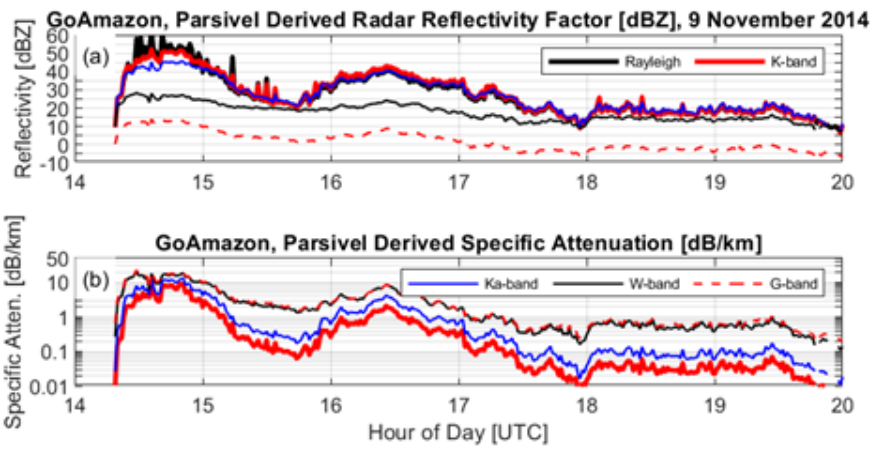
Figure 4. Surface Parsivel disdrometer derived radar effective reflectivity factor and rain specific attenuation. ( a ) Radar effective reflectivity factor assuming Rayleigh scattering and scattering at K-, Ka-, W-, and G-bands; ( b ) rain specific attenuation at radar K-, Ka-, W-, and G-bands.